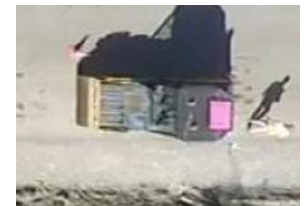
Figure 2. Machinery with magenta plate